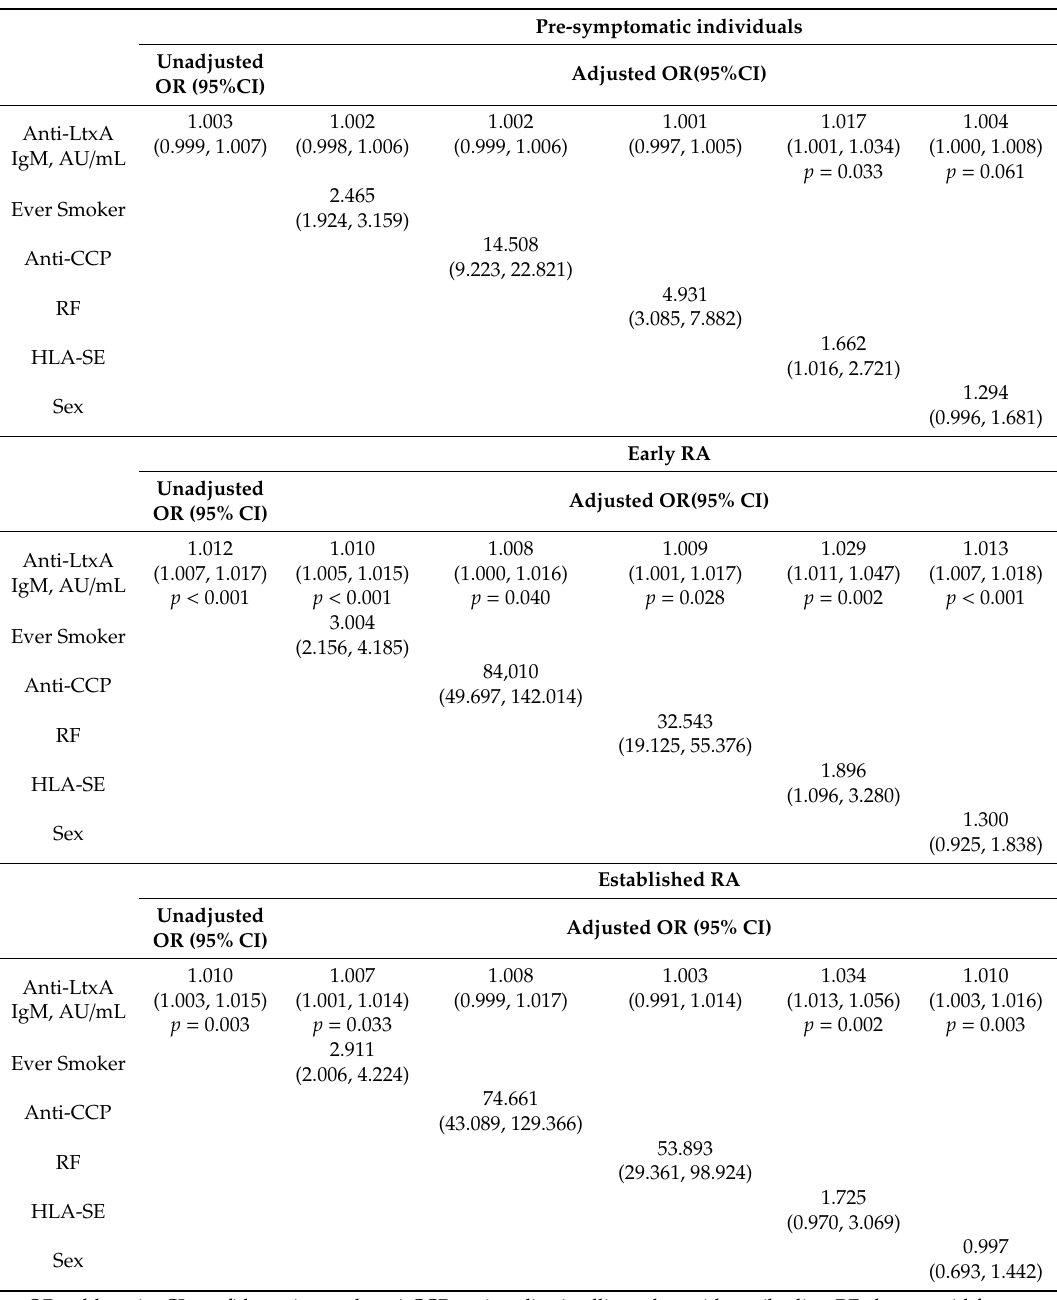
Table 4. Predictive value of anti-LtxA IgM levels for development of